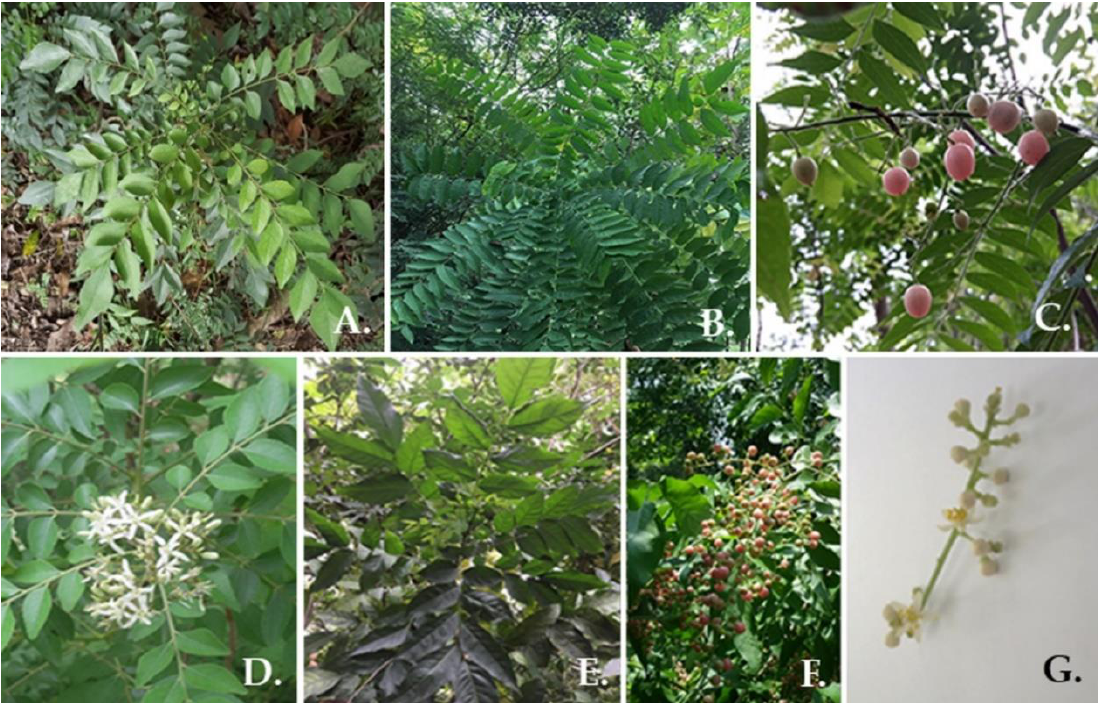
Figure 1. General morphology of plants. ( A ) PSRU-RUT001 (foliage of unknown plant species), ( B ), Clausena excavata plant (PSRU-RUT003), ( C ) Fruits of C. excavata , ( D ) flowers of C. excavata , ( E ) Clausena harmandiana plant (PSRU-RUT005), ( F ) Fruits of C. harmandiana and ( G ) flowers of C. harmandiana.